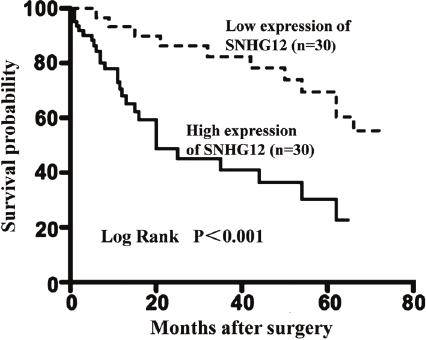
Figure 2. Prognostic signi fi cance of high and low expression of small nucleolar RNA host gene 12 ( SNHG12 ) in colorectal cancer patients.